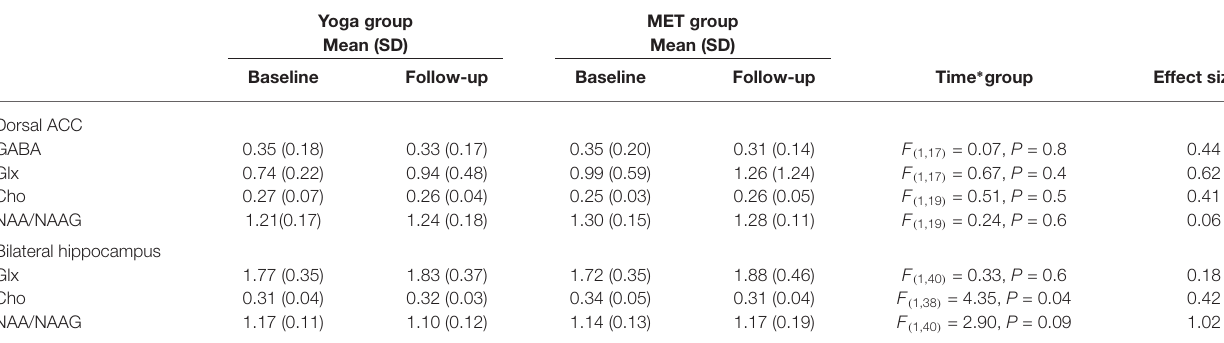
TABLE 3 | Proton magnetic resonance spectroscopy ( 1 H-MRS) signal intensity ratio measures for yoga and MET groups. Yoga group MET group Mean (SD) Mean (SD) Baseline Follow-up Baseline Follow-up Time ∗ group Effect size Dorsal ACC GABA